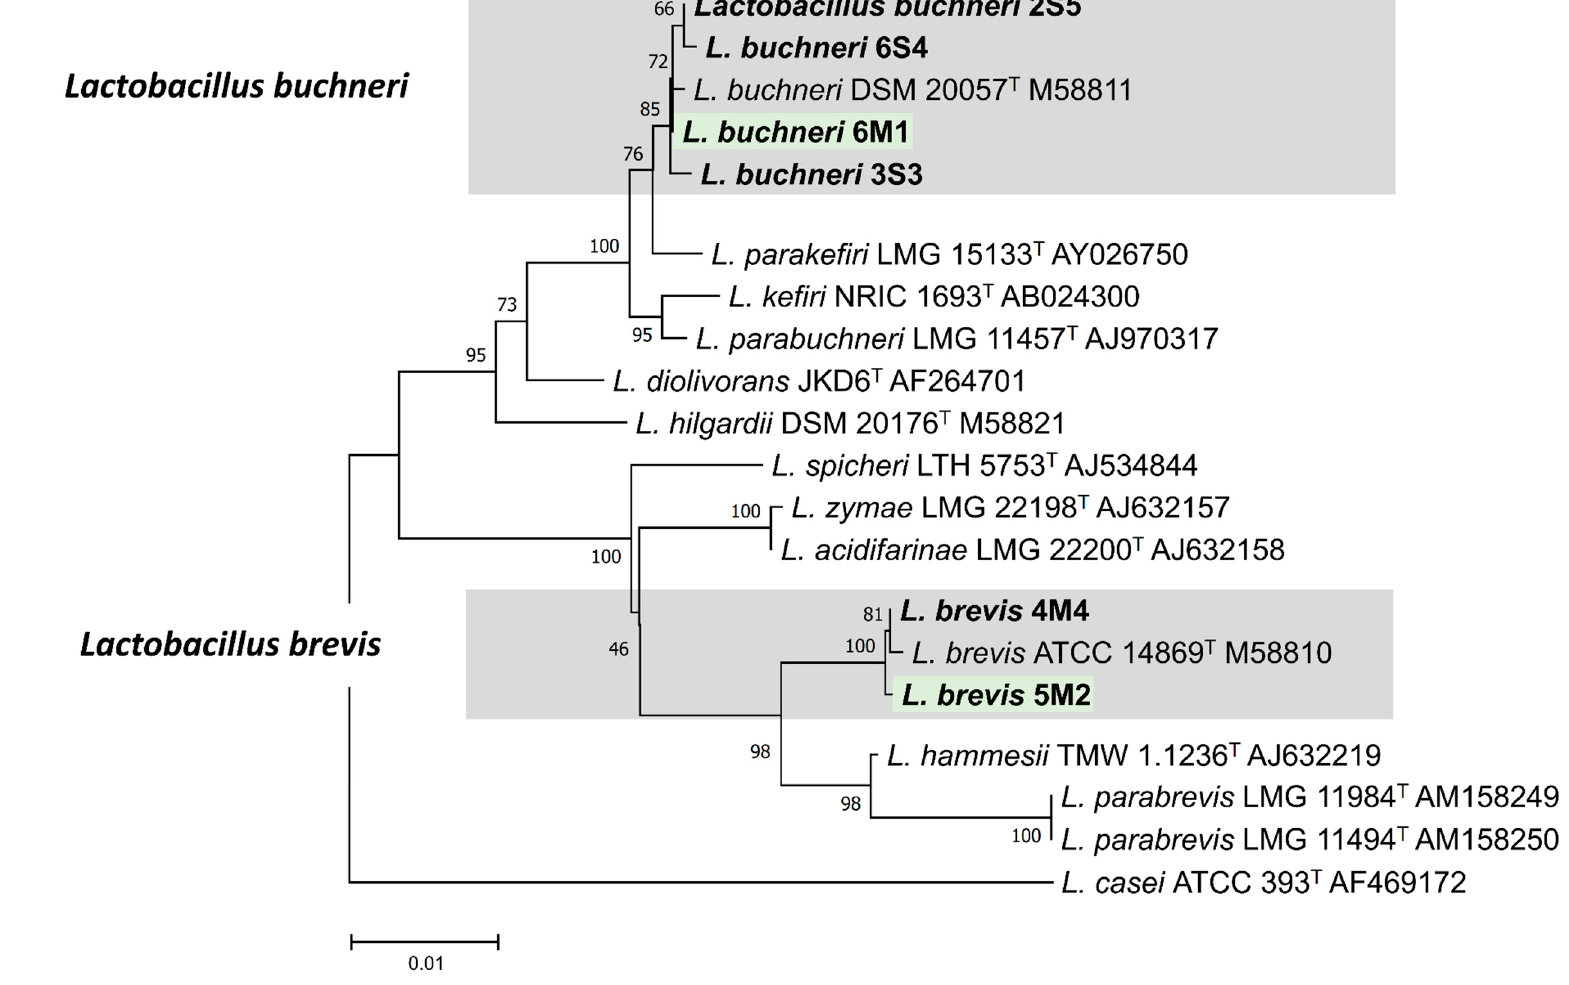
Figure 4. Phylogenic trees of the 16S rRNA gene sequences of 2S5, 3S3, 4M4, 5M2, 6S4, and 6M1 isolates.